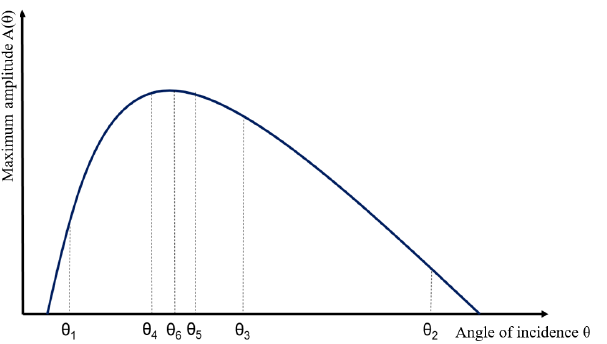
Figure 4. The bisection optimization method for finding the opti- mal angle of incidence.